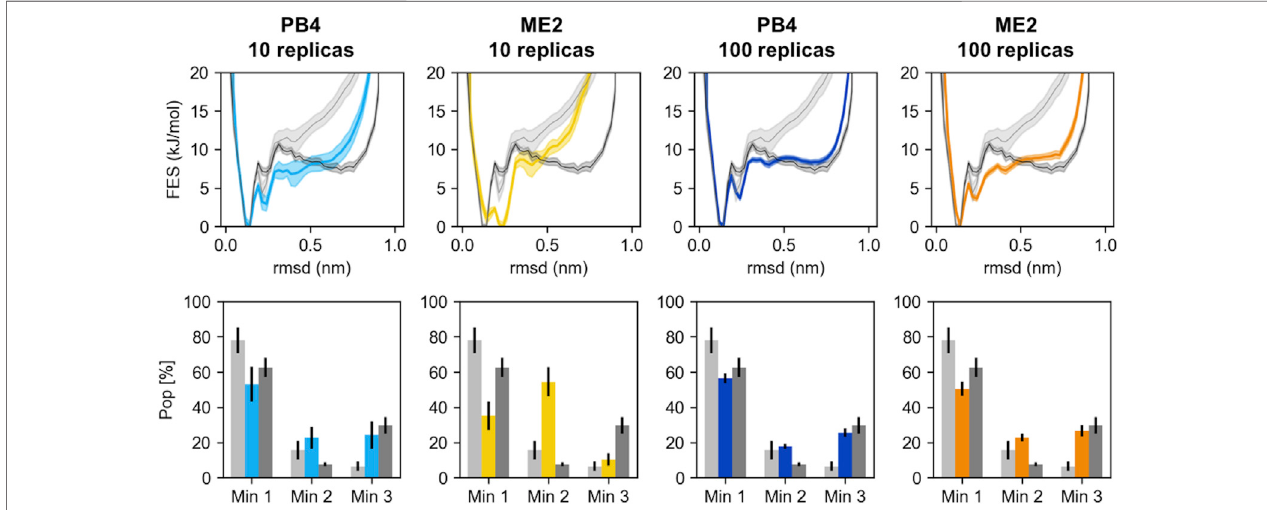
FIGURE4| TheRMSDfreeenergies (toppanels) andthepopulationofthethreemainchignolinminima (bottompanels) arerepresentedfordifferentsimulations (PB4orME2,witheither10or100replicas).Theresultsfromthepriorsimulation,performedwiththeamber99sb-ildnforce fi eldandnoSAXSrestraints,arerepresented in light grey. The results from the reference simulation, performed with the DES-amber force fi eld and whose back-calculated SAXS intensities were used as target, are represented in dark grey. The errors are estimated via block-average analysis; the free energies are shifted to set their minimum to 0.